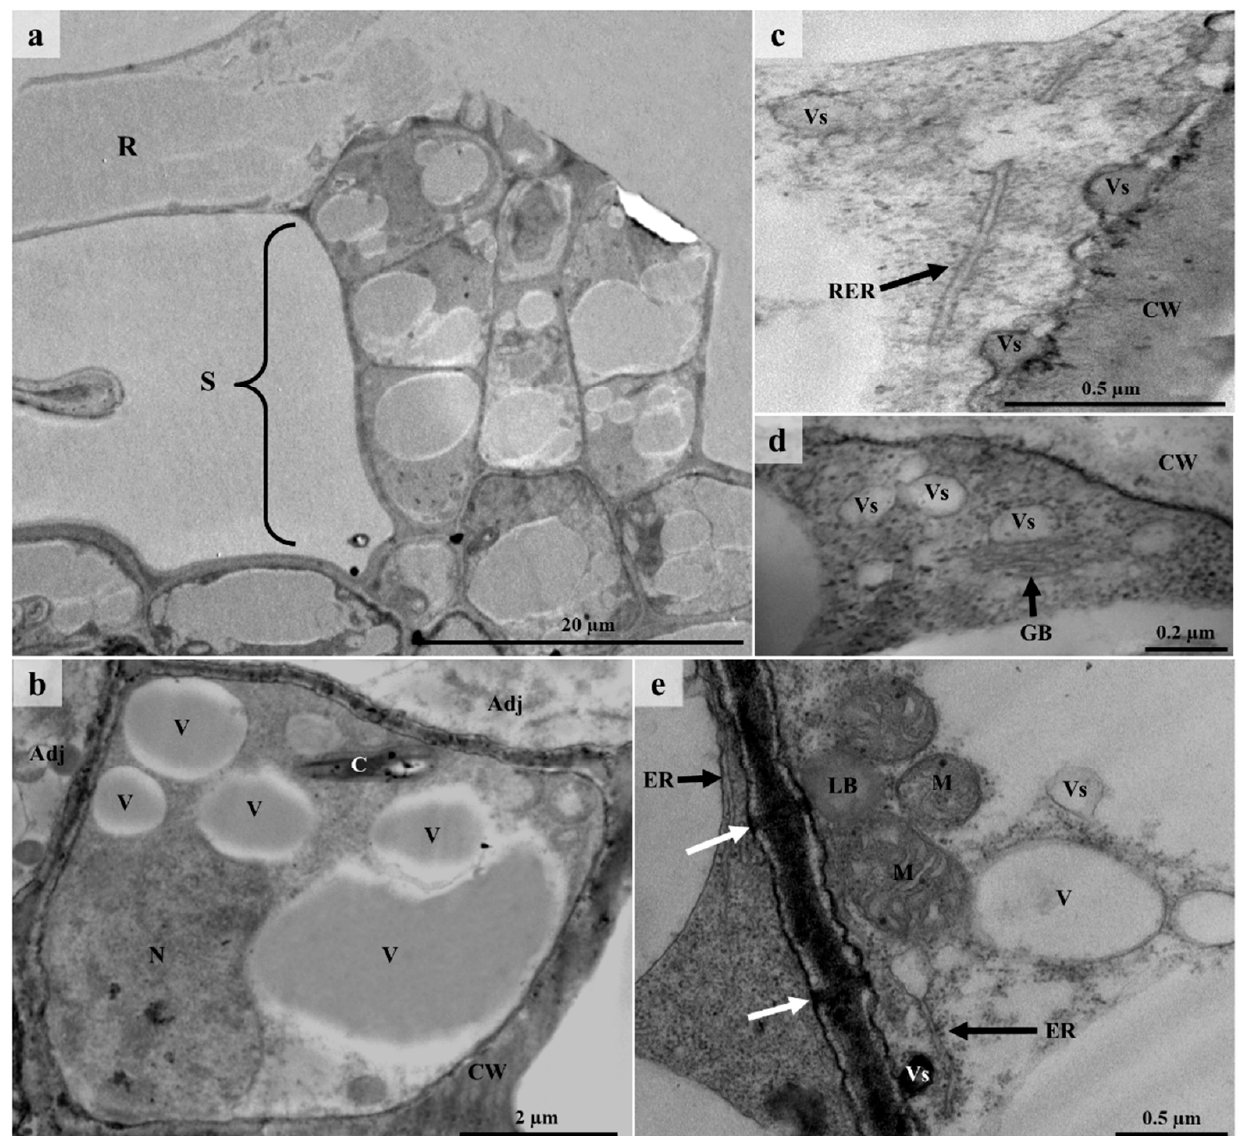
Figure 9. TEM micrographs of lepidote trichome stalk cells. ( a ) Section through the stalk cells and radial cell. Large and small vacuoles surrounded by dense cytoplasm and other organelles can be seen in the stalk cells. ( b ) Single stalk cell containing dense cytoplasm rather numerous vacuoles, a large nucleus, and a chloroplast. ( c ) Rough endoplasmic reticulum and vesicles at the periphery of a stalk cell wall. ( d ) Vesicles and Golgi body present in stalk cells. ( e ) Cell wall between two adjacent stalk cells with visible plasmodesmata (white arrows). Vacuoles, numerous mitochondria, endoplasmic reticulum, and vesicles can be seen at the periphery of these cells. Note the presence of the electron dense vesicle and lipid body next to the cell wall. R—Radial cell, S—Stalk,